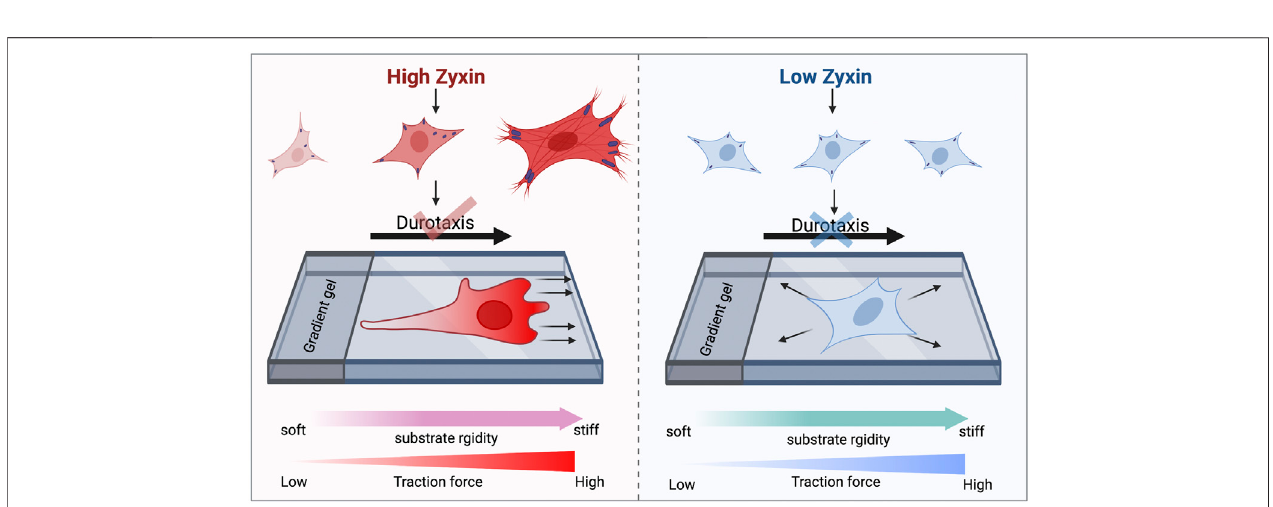
FIGURE 6 | Zyxin facilitates substrate rigidity sensing and impacts on durotaxis. Cells with high zyxin levels can sense substrate rigidity through modulating actin, focal adhesion, and traction stress, allowing the cells to move up rigidity gradients (left panel) . Cells with low zyxin levels (right panel) are not able to sense substrate rigiditybecausetheyhavelosttheabilitytotunecellularactin,focaladhesion,andtractionstressinresponsetochangesonsubstratestiffness.Therefore,thesecellsare not able to perform durotaxis and they migrate randomly in all directions.